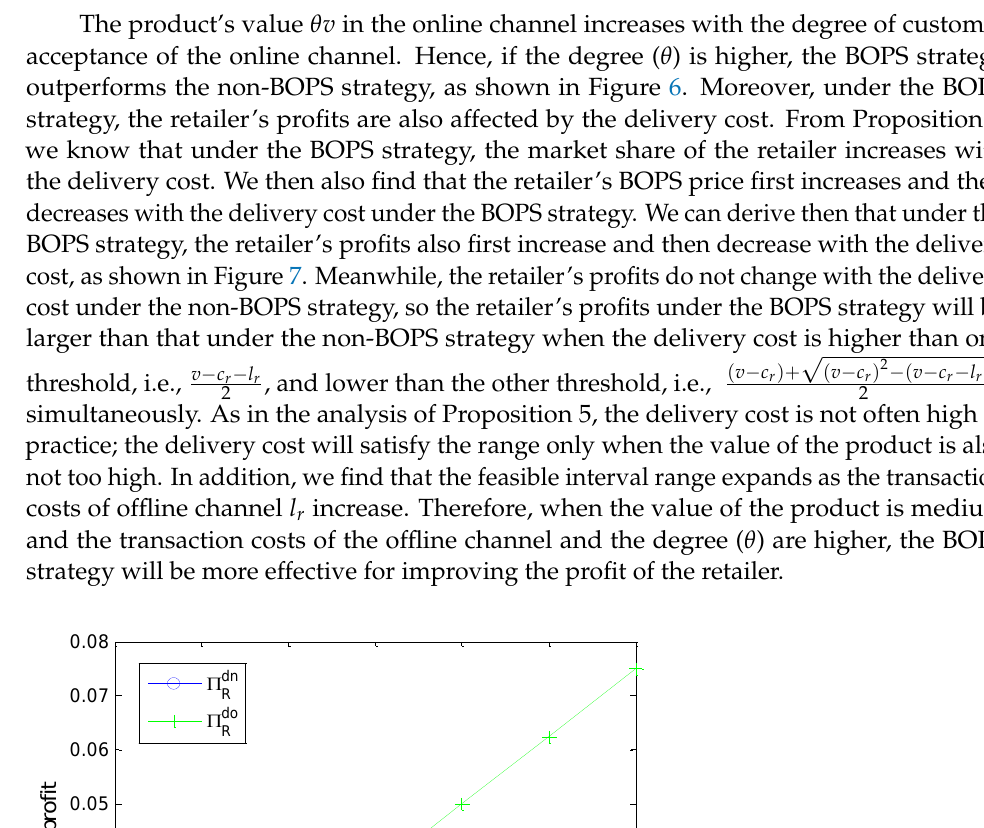
Figure 7. Impact of 𝑏 𝑒 on retailer’s profits under competition case. Zhang et al. [3] also studied whether the retailer should adopt the BOPS strategy under a competition case. The result of Zhang et al. [3] expressed that when the degree of customer acceptance of the online channel ( θ ) was lower than a threshold, the BOPS strategy was the best choice for the retailer. On the contrary, the result of our paper shows that only when the degree is higher than a threshold, the BOPS strategy may be benefit to the retailer. The main reason for the opposite result is the different pricing strategies. In the model of Zhang et al. [3], the retailer used “same product same price” strategy, which leaded to lower pricing in offline channels if the degree ( θ ) is lower. It means that when the retailer adopts non-BOPS strategy, his profit is also lower. Under this condition, when the retailer adopts the BOPS strategy, his profit will increase due to the increase of his market share. In our model, the retailer uses “same product different price” strategy, which means that under the non-BOPS strategy, the offline price is not affected by the degree ( θ ). Proposition 3 also confirms this conclusion. Hence, under the non-BOPS strategy, when the degree ( θ ) is lower, the offline profit can still be maintained at a normal level. Under this condition, the BOSP strategy is a double-edged sword for the retailer. On the one hand, the BOSP strategy may improve the retailer’ market share and hence